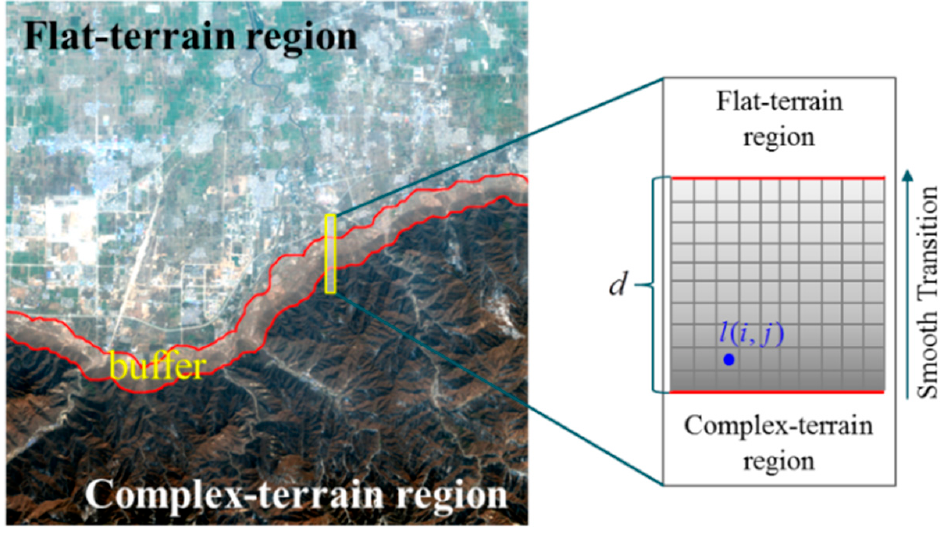
Figure 5. Displacement field mosaic of flat-terrain and complex-terrain region. Concretely, supposing o f is the final mosaicked displacement field, it is calculated as